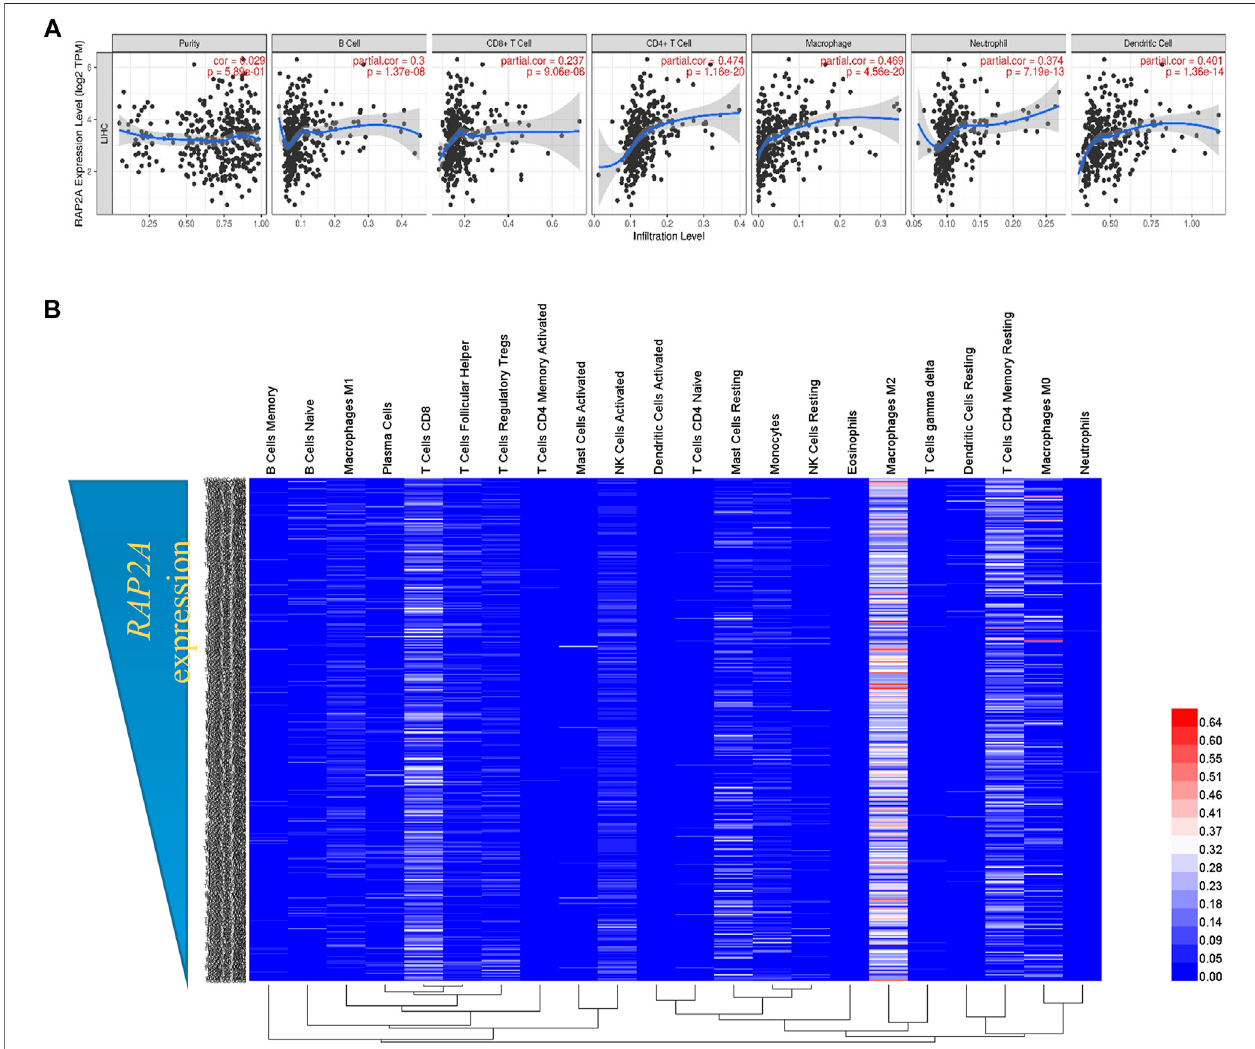
FIGURE 9 | Association of RAP2A gene with tumor immunity in TCGA-LIHC dataset. (A) TIMER analysis showing the correlation of RAP2A expression with an abundanceofsixdifferentimmunecelltypesinTCGA-LIHCdataset. (B) CIBERSORTanalysisshowingrelativefractionsof22differentimmunecelltypesinHCCtissues (represented by rows) arranged in order of high RAP2A expression (top) to low RAP2A expression (bottom).